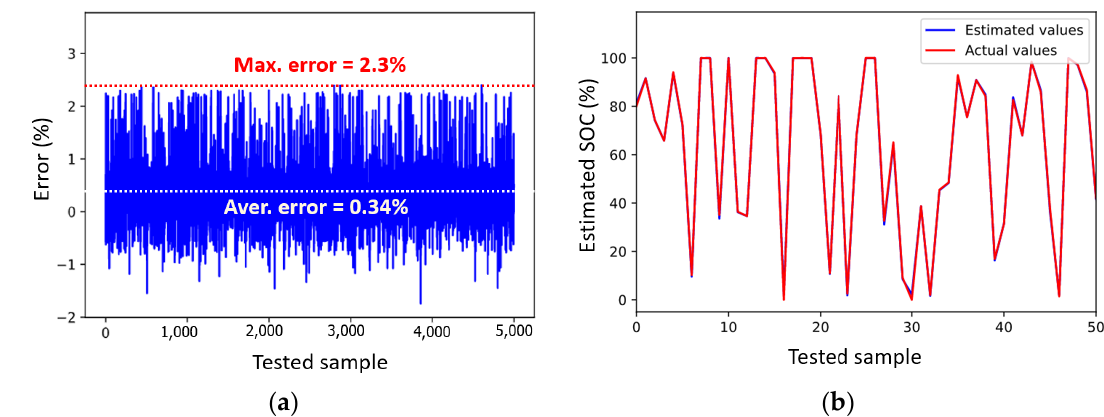
Figure 5. Test results of the trained ANN with 5,000 random samples: ( a ) error of the estimated SOC, and ( b ) estimated and actual SOCs.